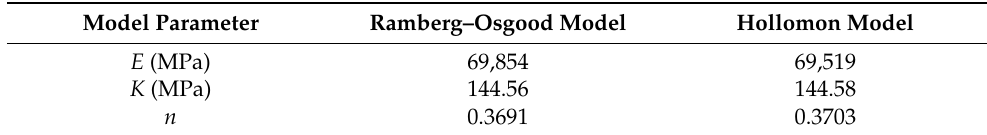
Figure 5. Measured and simulated true strain–stress curves for 1050 Al alloy (the scale for the d σ /d ε curve is shown on the right side); R–O stands for Ramberg–Osgood model [3,4]. Table 2. Fitted model parameters for two different material models.